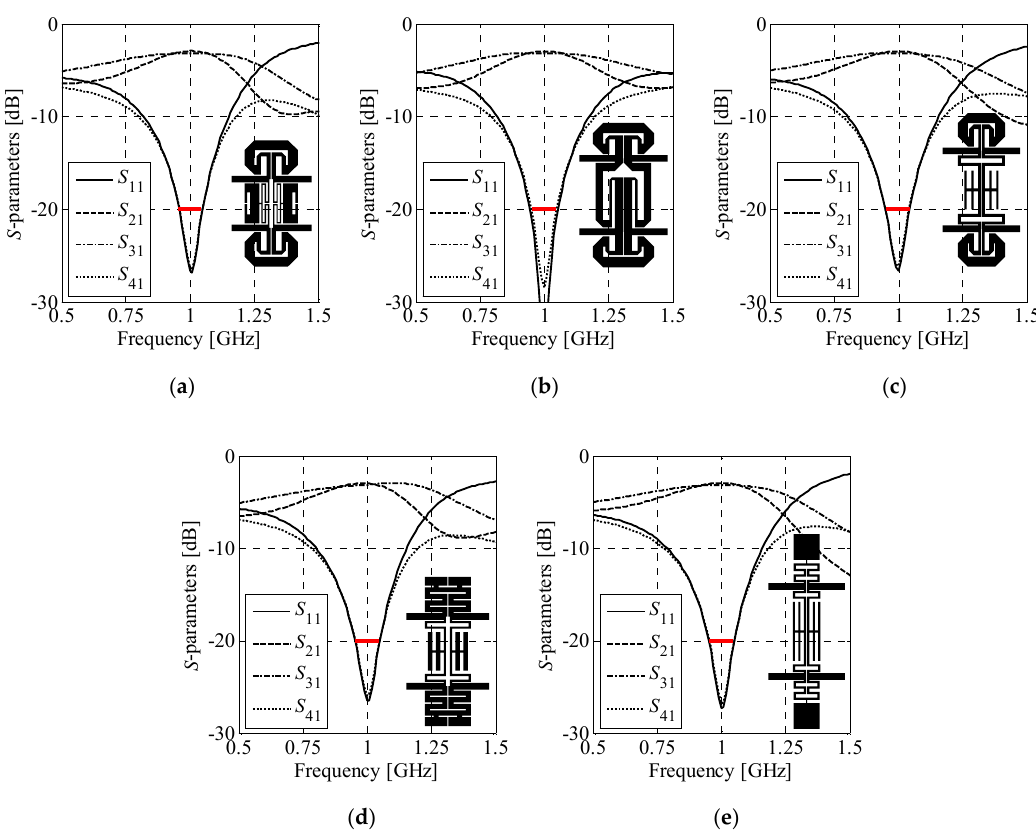
Figure 13. Frequency responses and geometries (in-scale) of optimized couplers (high-fidelity EM models) featuring acceptable performance: ( a ) B A (1,2) , ( b ) B A (1,4) , ( c ) B A (1,1) , ( d ) B A (2,1) , and ( e ) B A (3,1) .